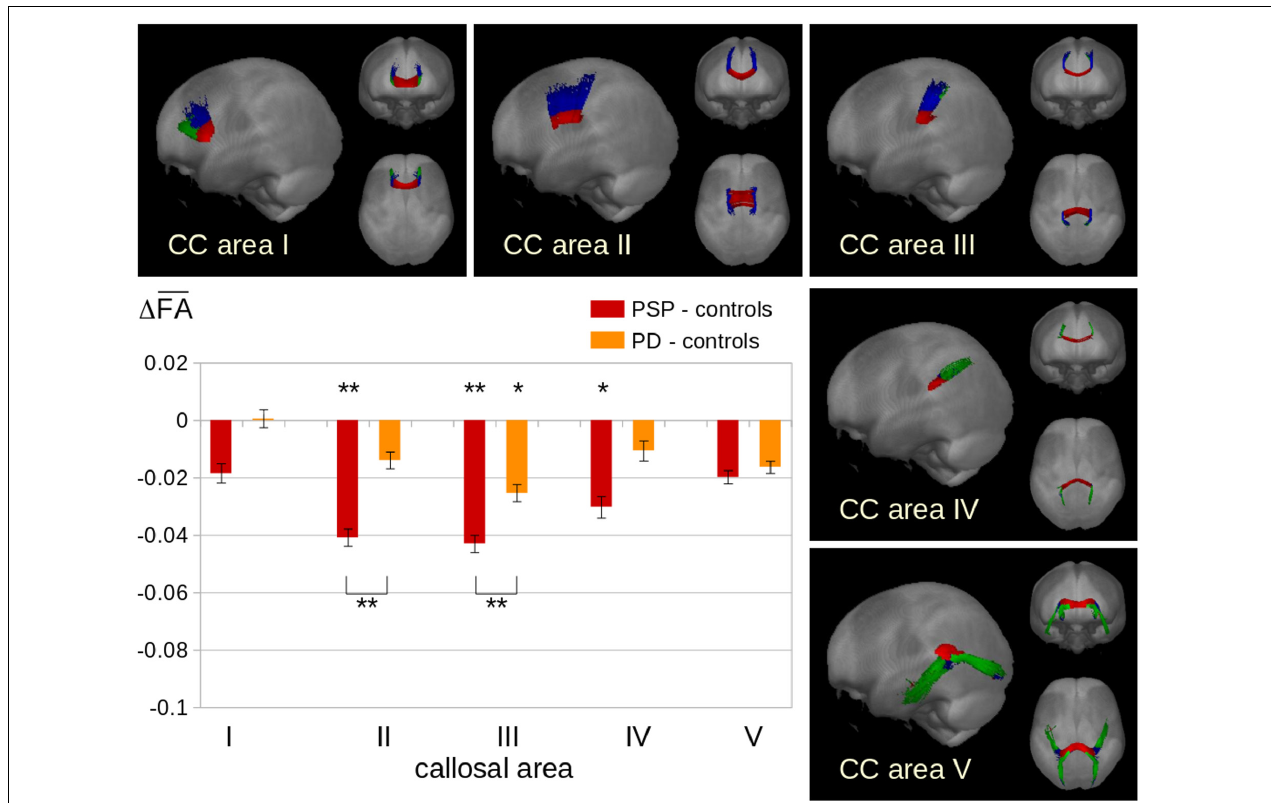
FIGURE 2 | Tractwise fractional anisotropy statistics (TFAS) for fiber tracts originating in callosal areas. Displayed are the differences ( (cid:49) ) in average FA values between patient groups and controls. PSP showed highly significantly reduced FA at the group level especially in areas II and III, while PD showed significantly reduced FA (however at a lower level compared to PSP) only in area III. * p < 0.01, ** p < 0.001, corrected for multiple